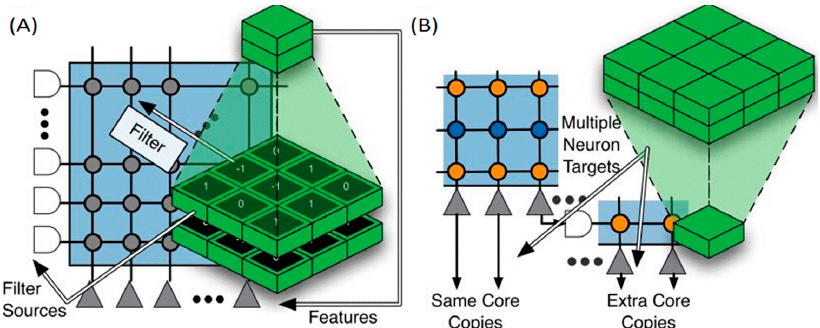
Figure 11. Mapping of a CNN to TrueNorth. ( A ) Convolutional network features for one group at one topographic location are implemented using neurons on the same TrueNorth core, with their corresponding filter support region implemented using the core’s input lines, and filter weights implemented using the core’s synaptic array. The inputs are represented with white shapes, and the grey triangles represent the neurons. The filter used in each case is implemented mapping the matrix of weights (the numbers in the green boxes) into the synaptic array (grey circles); ( B ) For a neuron (blue points) to target multiple core inputs, its output (orange points) must be replicated by neuron copies, recruited from other neurons on the same core, or on extra cores if needed [76].